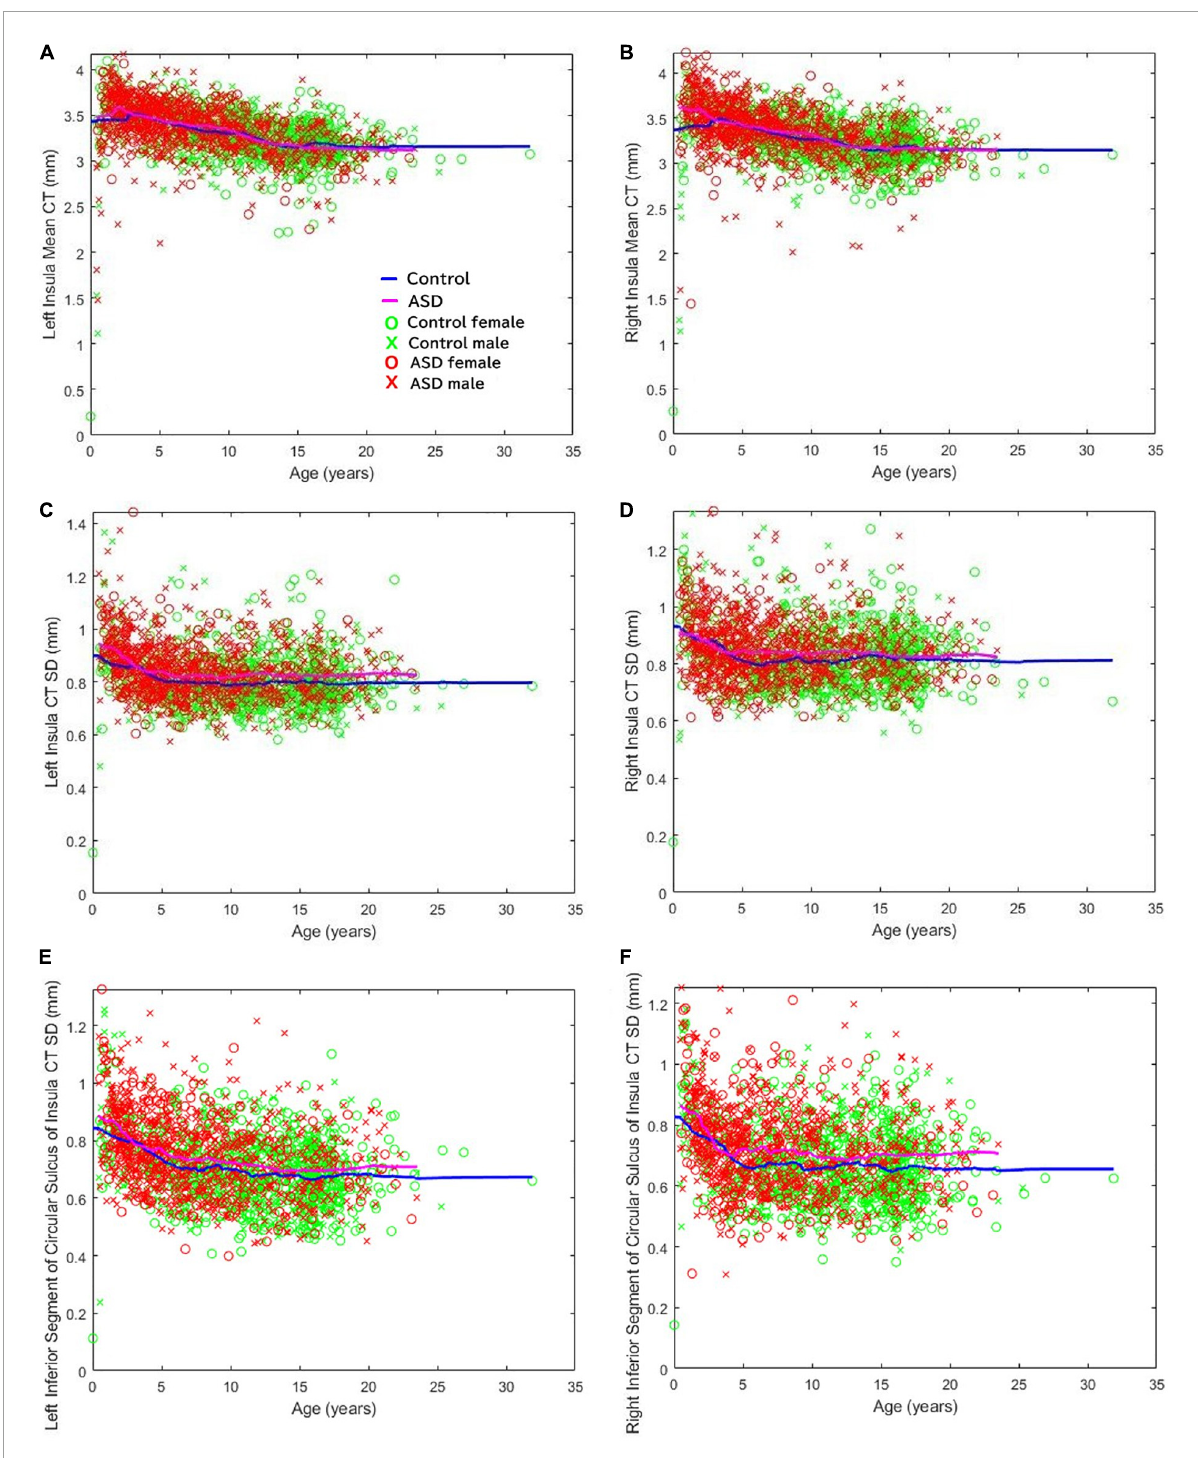
FIGURE5 Cortical thickness variability of several regions of the insula were found to be elevated in ASD. The mean cortical thickness of the (A) left and (B) right insula. Standard deviation of the cortical thicknesses of the (C) left and (D) right insula. Standard deviation of the thicknesses of the (E) left and (F) right inferior segment of the circular sulcus of the insula across all ages available (Levman et al.,